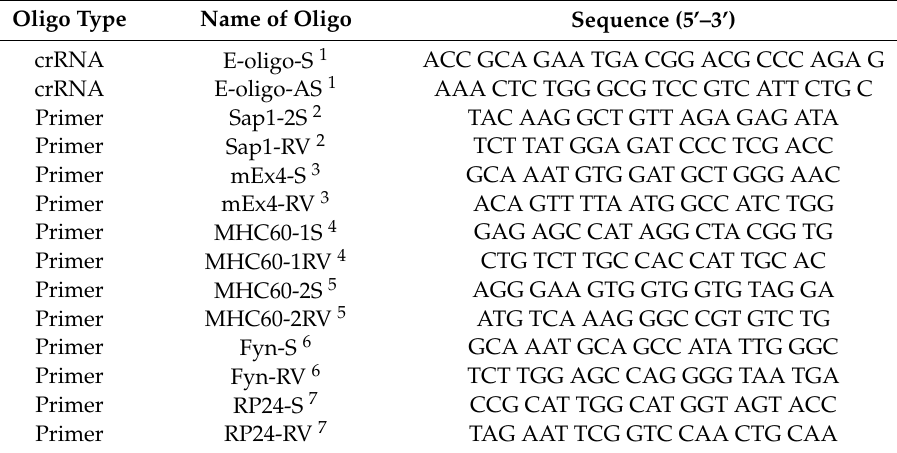
Table 1. Nucleotide sequences of oligonucleotides (oligos) used in this